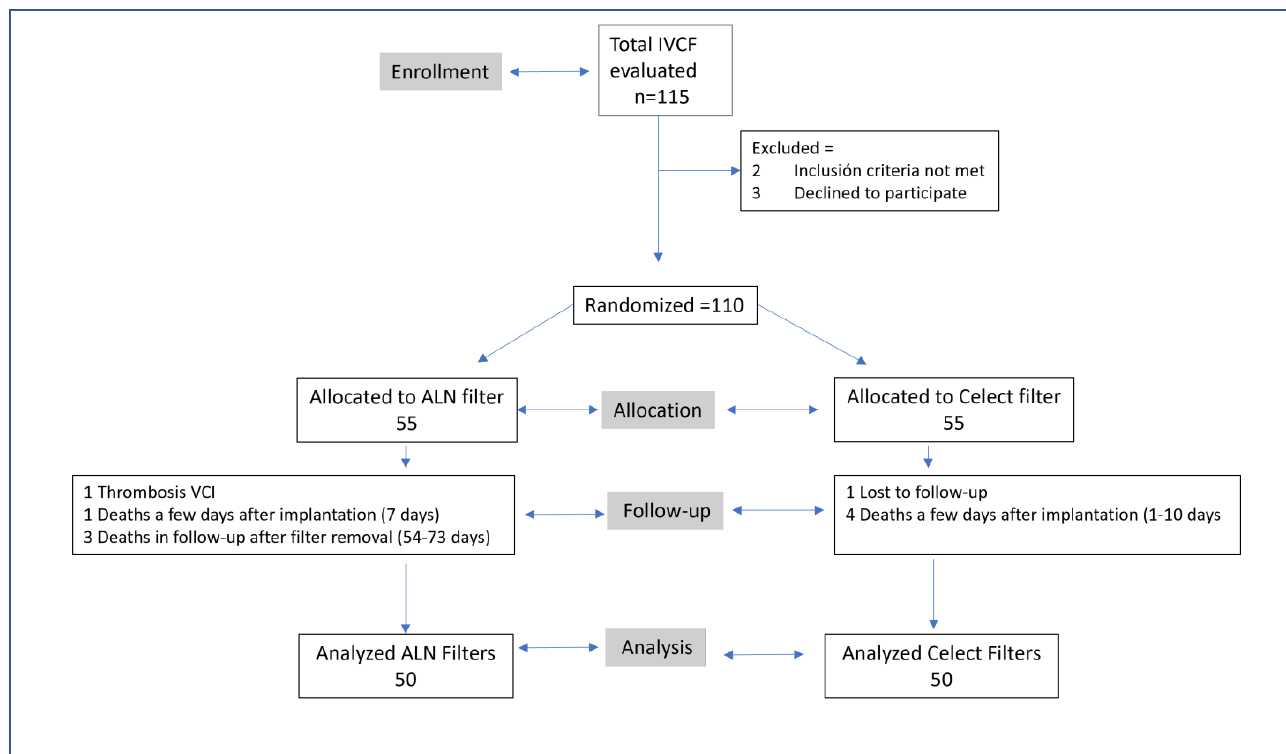
Figure 1. Consolidated standards of reporting trials diagram.